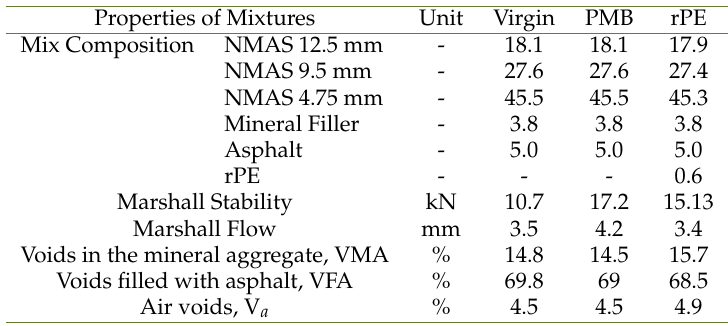
Table 3. Composition and properties of controlled (Virgin and PMB) and rPE mixtures Properties of Mixtures